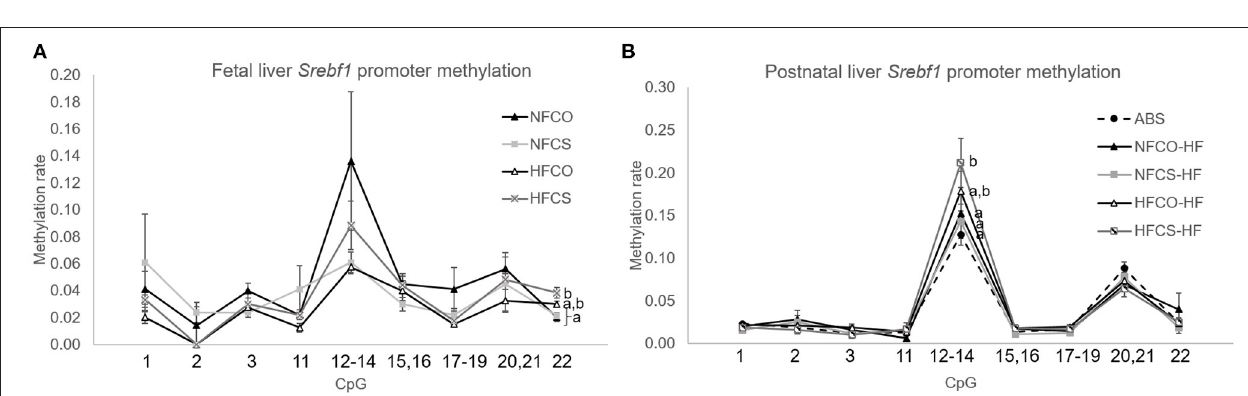
both HFCO-HF and HFCS-HF had higher methylation ( p < 0.05) in CpG1 and CpG3 than the ABS and NFCO-HF groups. Although lower leptin secretion accompanies CS, Lep methylation in VAT was unaltered amongst the various groups indicating a different mechanism for this gene regulation ( Supplementary Figure 4C